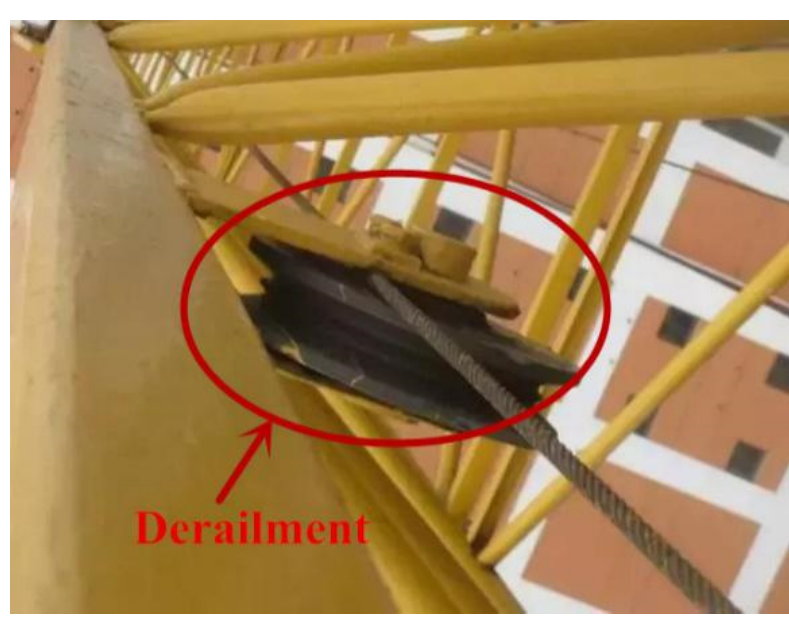
Figure 12. Derailment of wire rope .